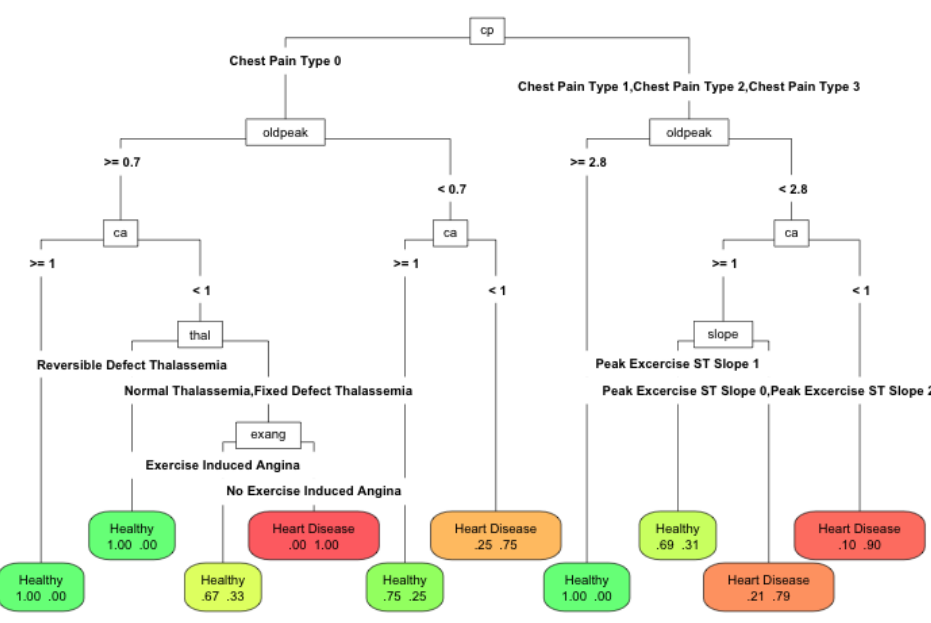
Figure 8. Performance of RPART using 66% of features with a maximum tree depth of 6.